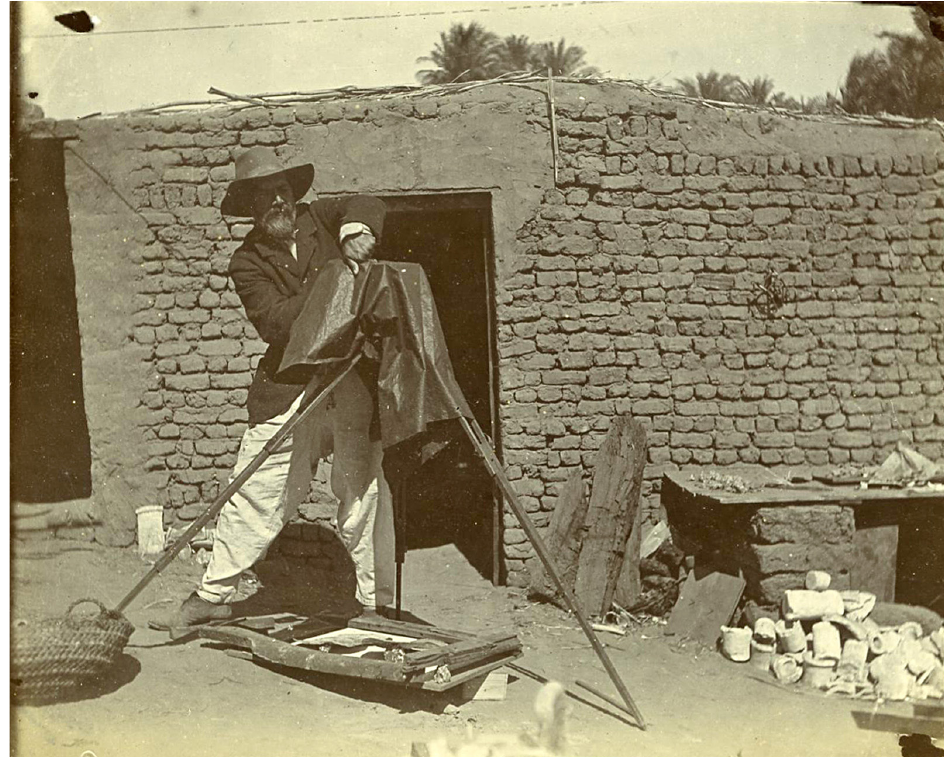
Fig. 1: ‘Flinders, taking Khasekhemui bronzes etc. in front of store hut’ (from Margaret Mur- ray’s photograph album, Abydos 1902). Petrie was a pioneer of archaeological photogra- phy as well as ‘the father of Egyptian archaeology’ (photo: Petrie Museum archive PMF/